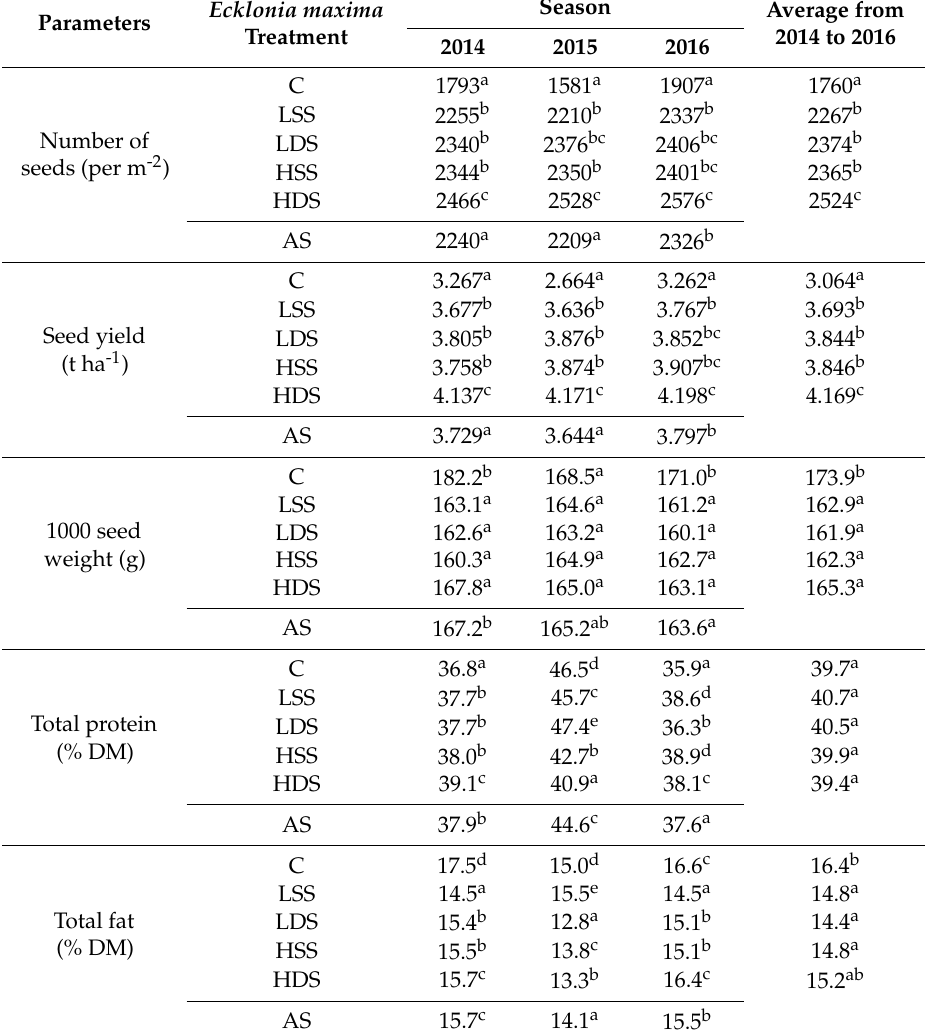
Table 5. Effect of Ecklonia maxima extract (Kelpak) treatment on yield and nutritional properties of soybean (average from